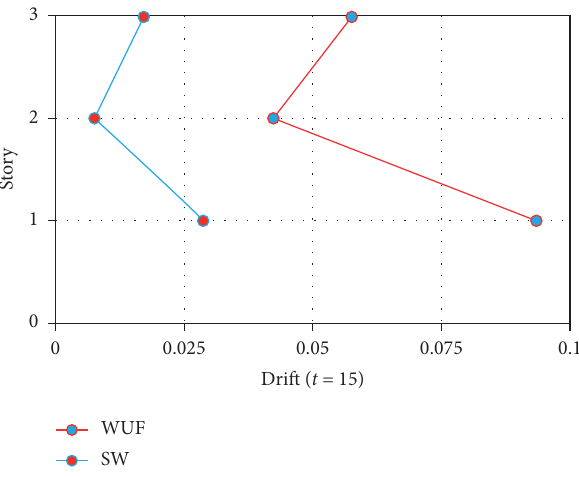
Figure 20: Story drift at target time t �